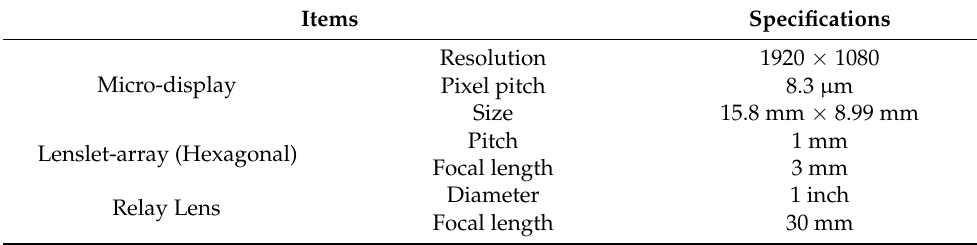
Figure 9. The full color displaying experiments using the OLED-based InIm system and holographic waveguide: ( a ) experimental setup for verifying the proposed method, and the resultant 3D images with their EIs ( b ) with and ( c ) without applying the proposed method. The EIs used for the displaying experiments are presented below the observed AR images. Table 2. Experimental specifications for the displaying experiments using the holographic waveguide and InIm